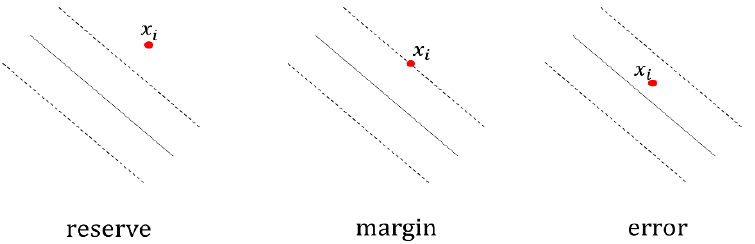
Figure 2. Sample states according to Karush–Kuhn–Tucker (KKT) conditions.